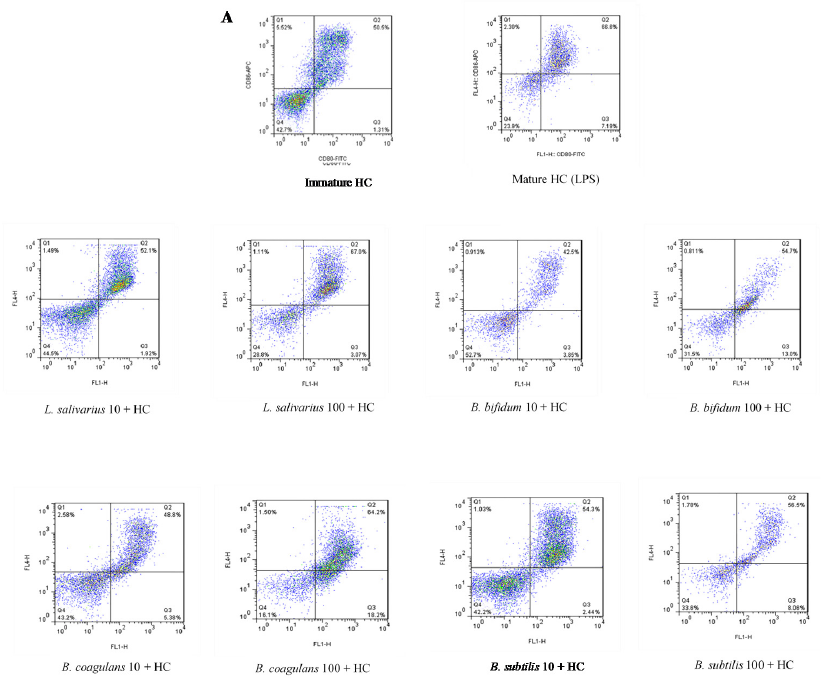
Figure 1. Microscopic and flow cytometric analysis of dendritic cells on the day 6 of culture ( A , B ) (magnification 40×); the cells in the gated population ( C ) were further analyzed for CD11C + /CD11b + expression ( D ) and CD80/CD86 expression ( E ). Int. J. Mol. Sci. 2020 , 21 , x FOR PEER